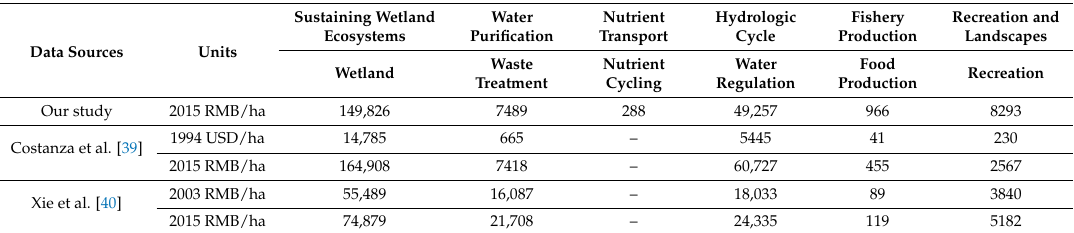
Table 6. The comparisons of studies on the value per unit area. USD: United States Dollar; 1994 USD: the price of USD in 1994; 2003 RMB: the price of RMB in 2003. The exchange rate for USD was from 1994, and the discount rate over the years was sourced from the People’s Bank of China.